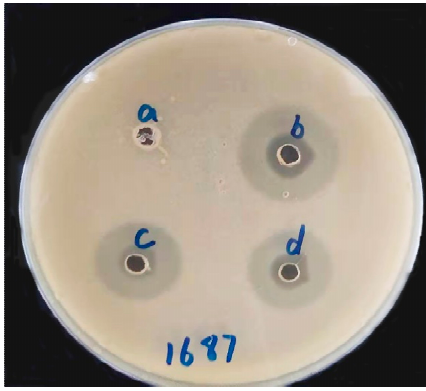
Figure 5. The inhibition zones of TIL-SLNs and TIL-nanogel against S. aureus 1687. Note: (a) control; (b) tilmicosin standard; (c) TIL-SLNs; (d) TIL-nanogel.